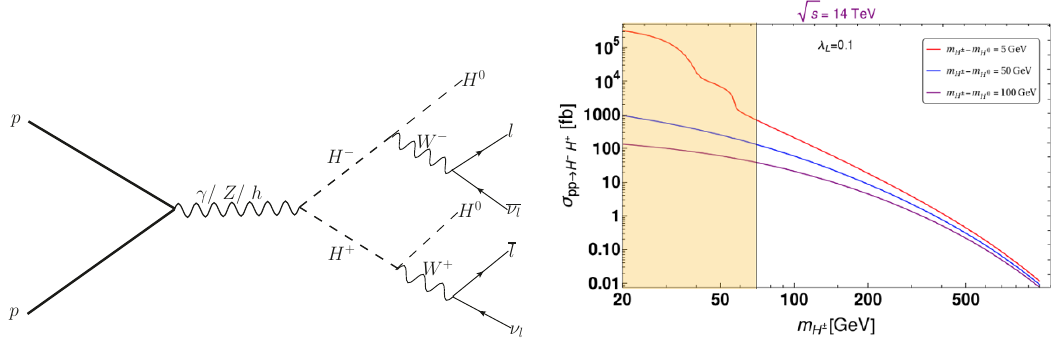
Figure 28 . [Left] Feynman graph for OSDL+ =E signature of IDM at LHC. [Right] Variation of T production cross-section (cid:27) (in fb) with m (= m +(cid:1) M ) in GeV for di(cid:11)erent choices H 0 pp ! H + H (cid:0) H (cid:6) p of m (cid:0) m for center-of-mass energy s = 14 TeV at LHC. LEP limit on charged scalar is H 0 H (cid:6) shown by the shaded